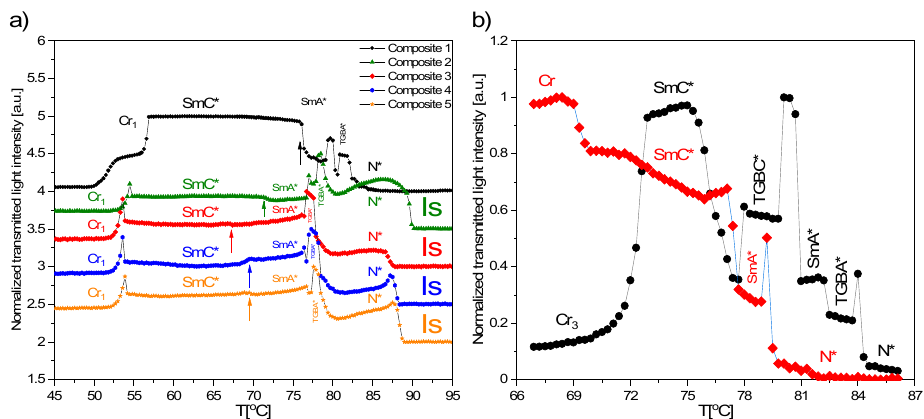
Figure 6. Normalized transmitted light intensity registered during cooling ( a ) and heating ( b ), rate = 3 ◦